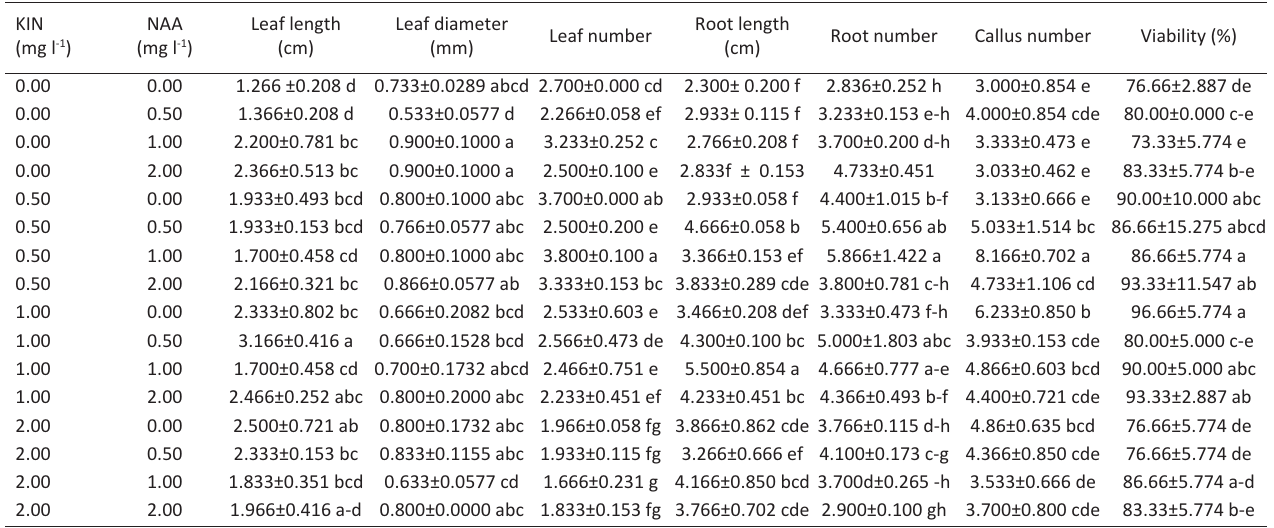
Table 4 ­ Mean comparison of the effect of different concentrations of KIN and NAA on measured characters of Fritillaria imperialis L. KIN (mg l ­1